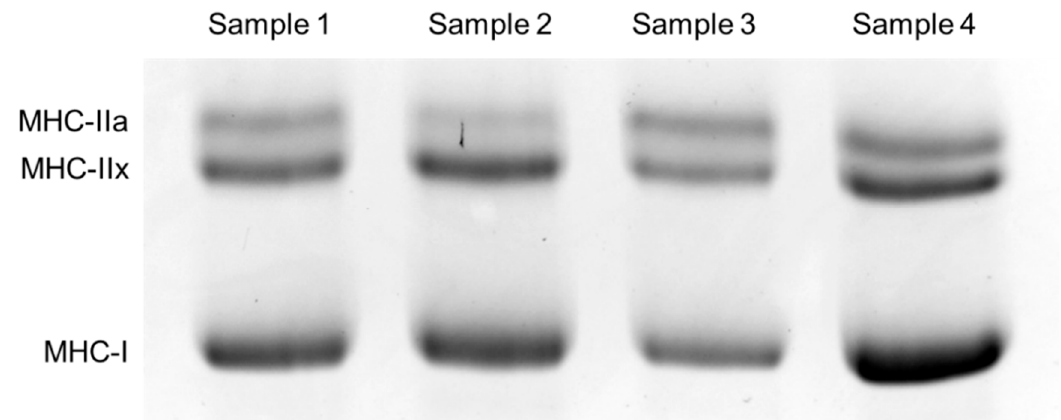
Figure 1. Typical image of myosin heavy-chain (MHC) isoforms determined by SDS-PAGE.